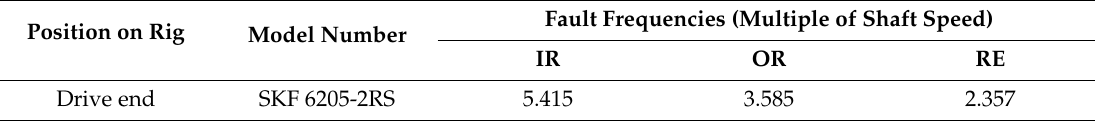
Table 2. Bearing details and fault frequencies.